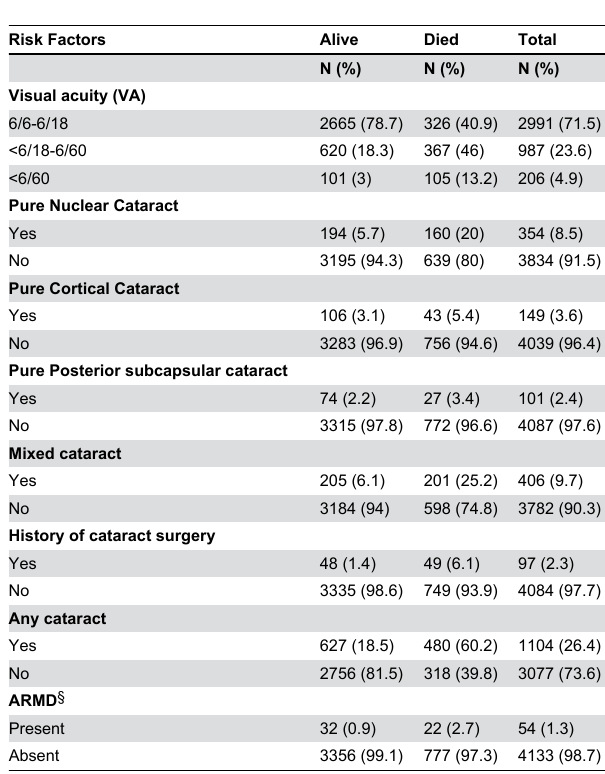
Table 2. Distribution of cataract morphology and other ocular risk factors for